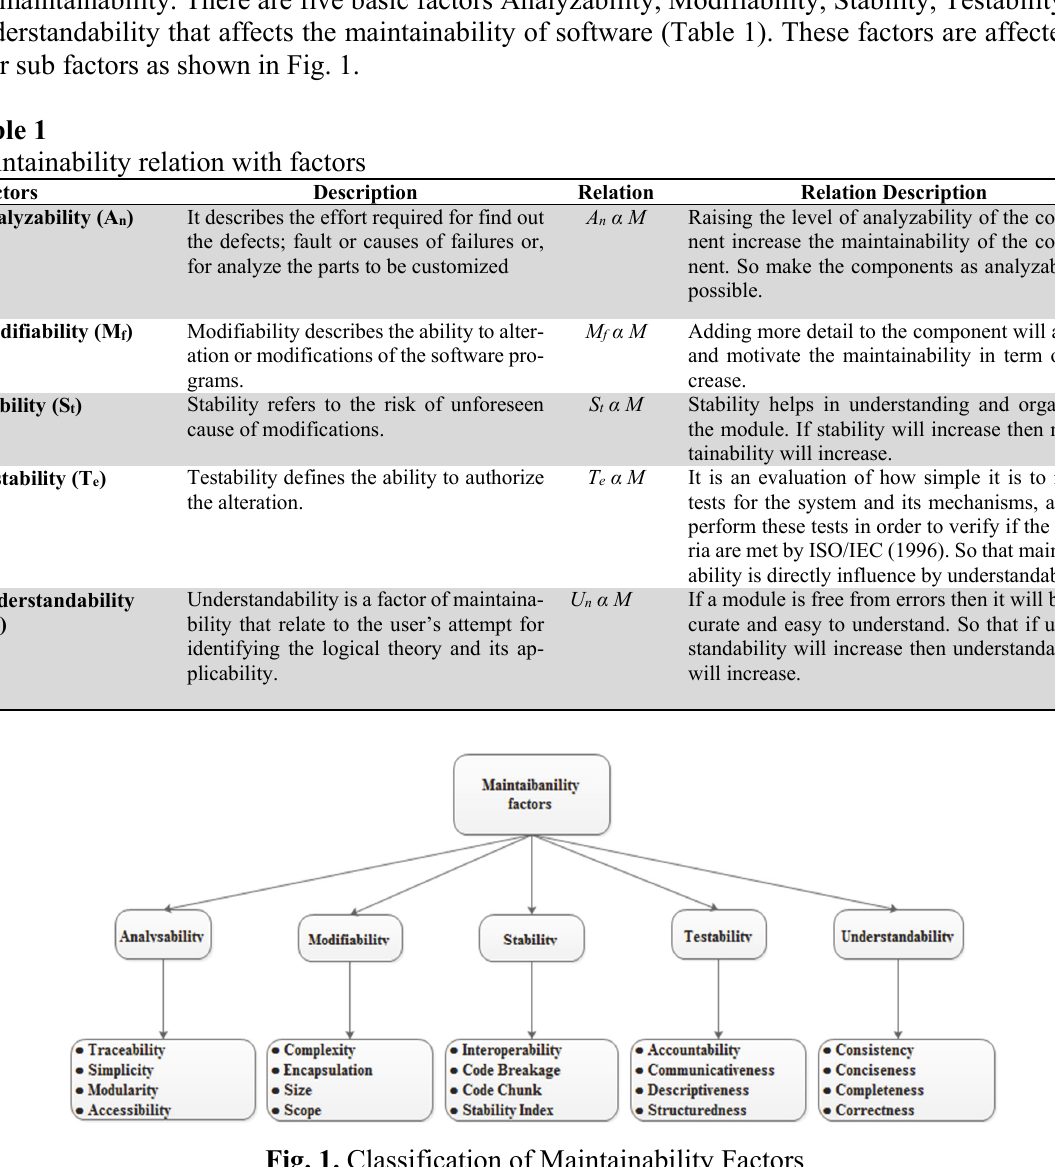
Fig. 1. Classification of Maintainability